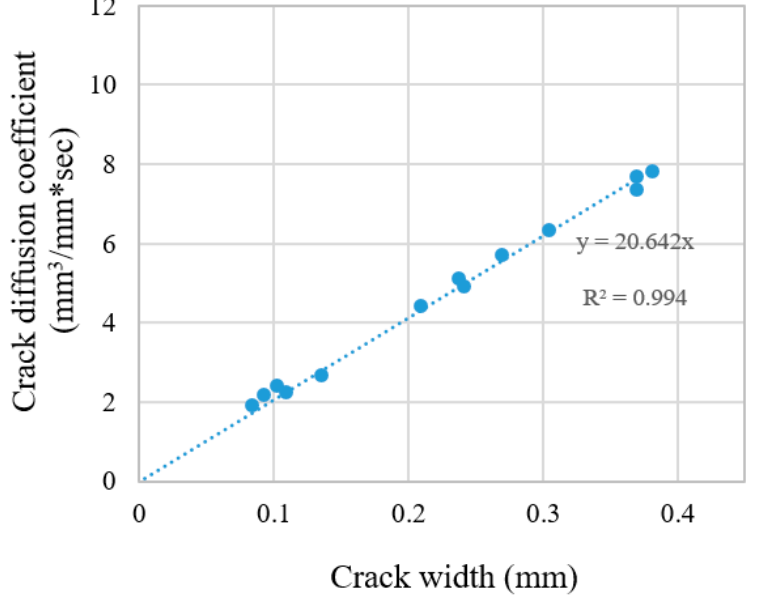
Figure 8. Crack diffusion coefficients versus crack width of the mortar specimens. Figure 8. Crack di ff usion coe ffi cients versus crack width of the mortar